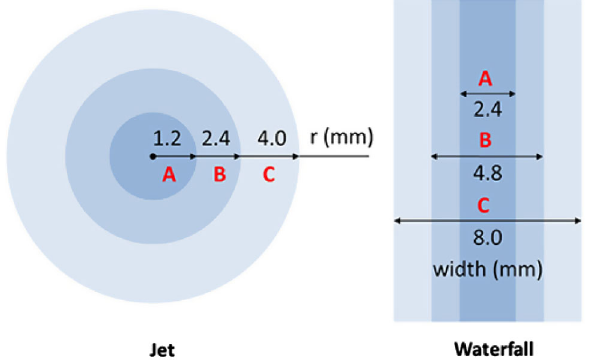
FIG. 3. Different regions for the comparison between the liquid mercury/powdery tungsten jet and the grain waterfall. The regions are marked in transverse sections of the targets ( A ∈ B ∈ C ).